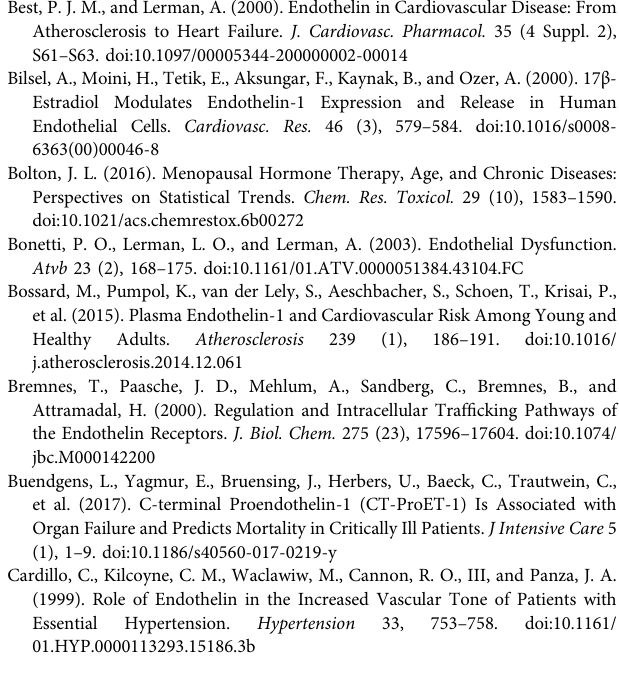
Frontiers in Aging |